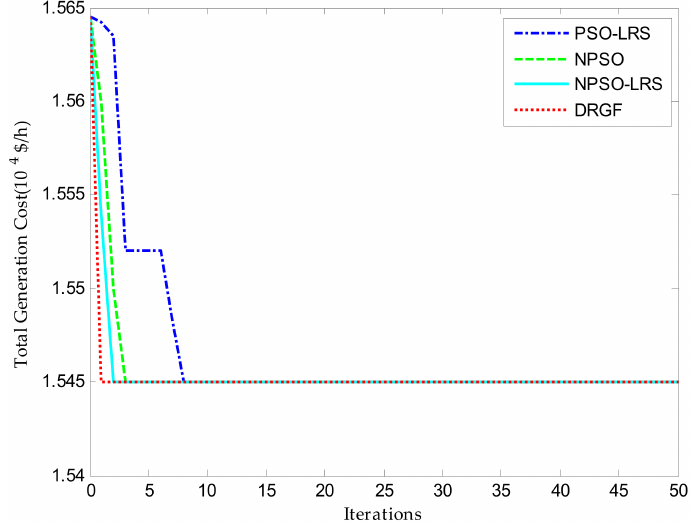
Figure 3. Optimization curves of six units test system. PSO-LRS: particle swarm optimization-simple local random search; NPSO: new particle swarm optimization; NPSO-LRS: new particle swarm optimization- simple local random